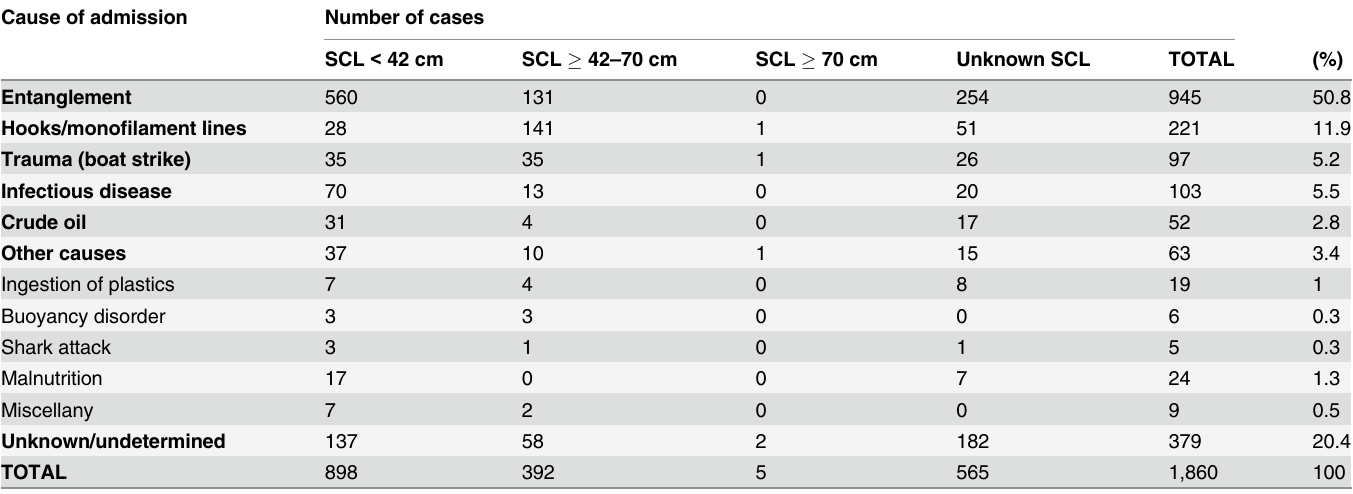
Table 1. Number of cases and frequency distribution by causes of admission in loggerhead turtles with different straight carapace length (SCL) stranded during the period 1998 –